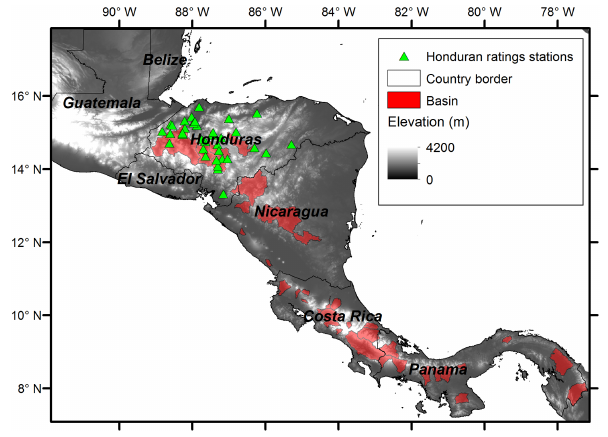
Figure 1. The Central American region, elevation distribution and the location of the studied basins and the Honduran rating